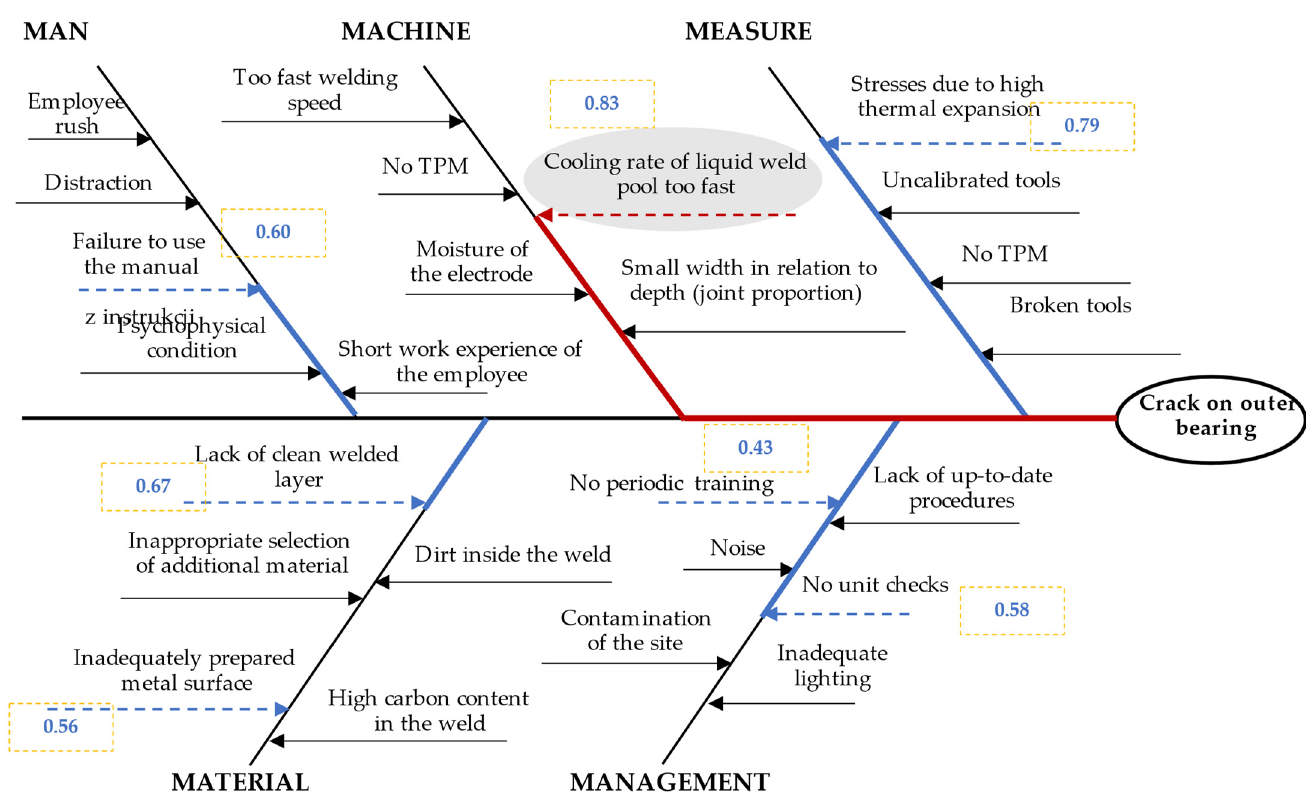
Figure 7. Ishikawa diagram for crack on the outer hull of four-point bearing to choose the main cause.